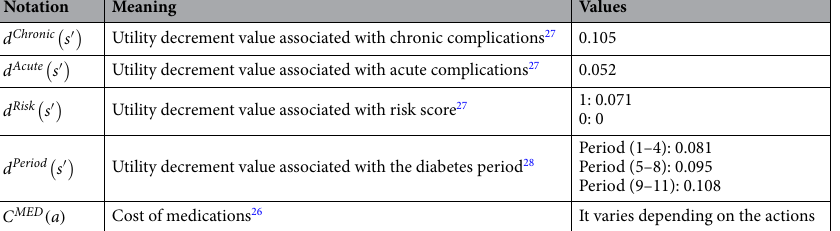
Table 4. Decrement values for the reward function.